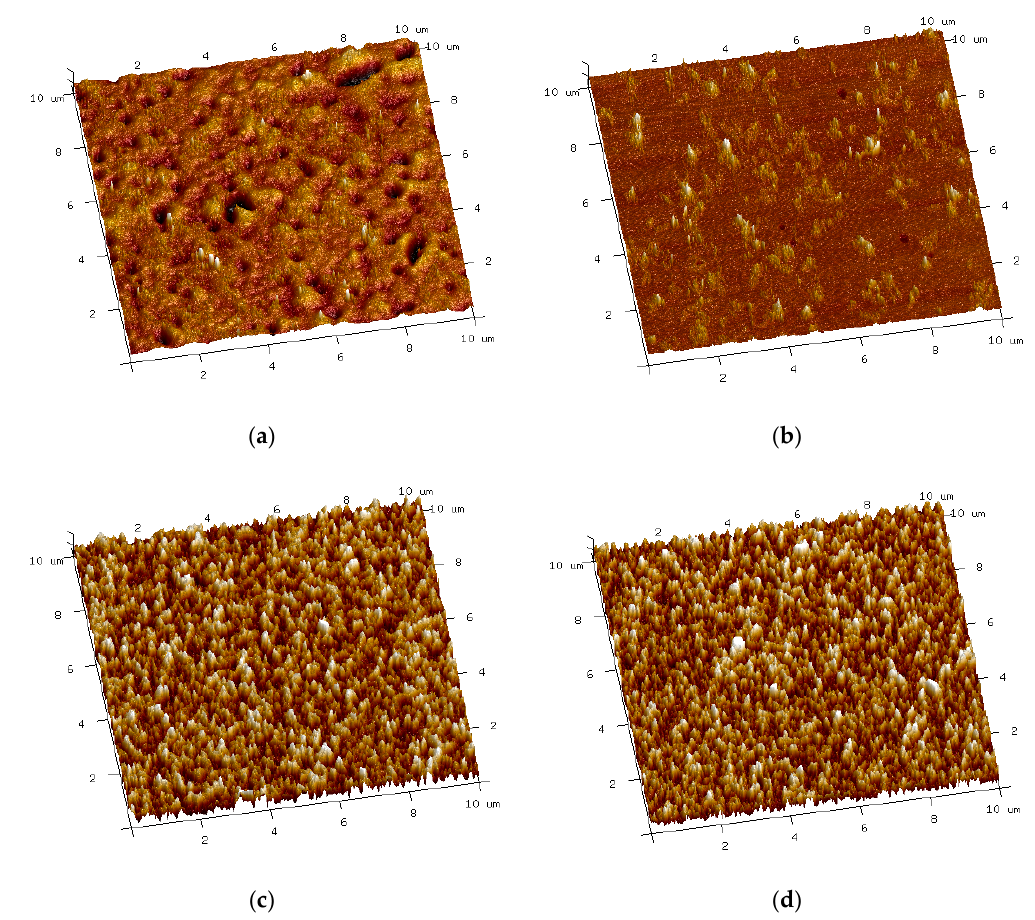
Figure 2. Topography of coatings: ( a ) SiO 2 (sol S) coating; ( b ) SiO 2 + Zn (sol SZn10) coating; ( c ) Modified SiO 2 coating (sol MH); ( d ) Modified SiO 2 + Zn coating (sol MHZn10).